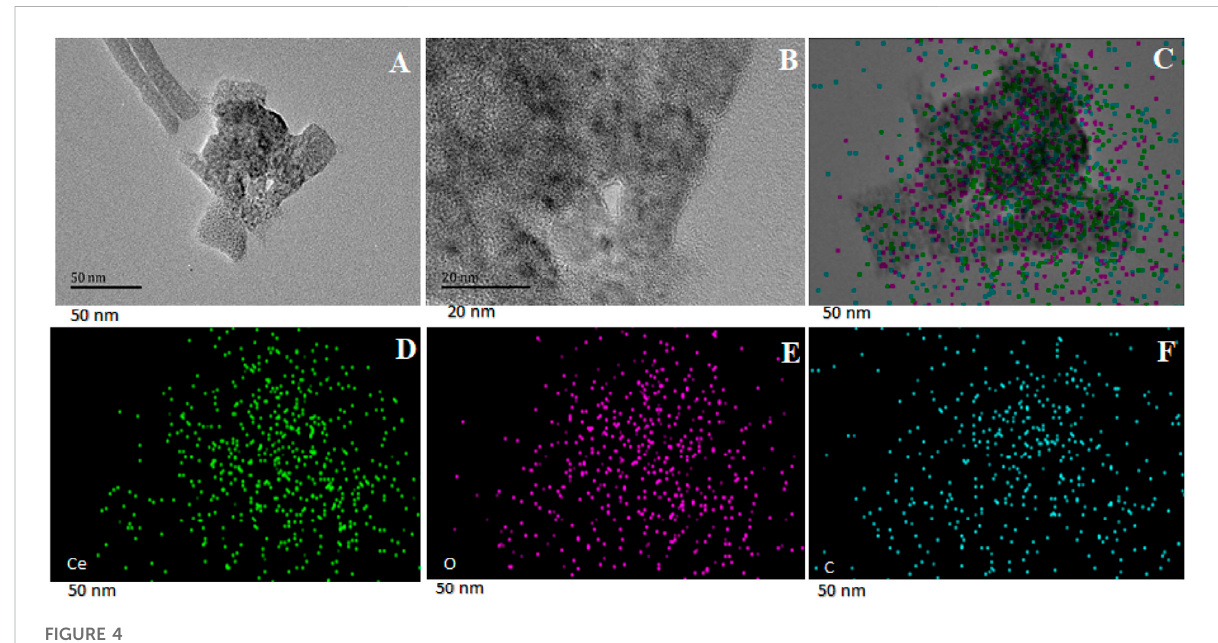
FIGURE 4 HRTEM images of Ce-MOF (A,B) and EDS elemental mapping (C – F) .